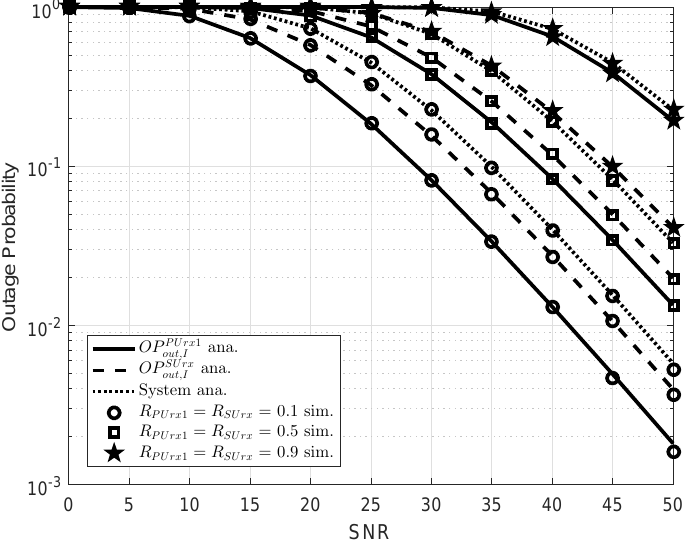
Figure 3. Scheme 1: Outage performance of PUrx 1 and SUrx versus transmit SNR at source when R PUrx 1 = R SUrx ( a 1 = 0.85, η = 1).